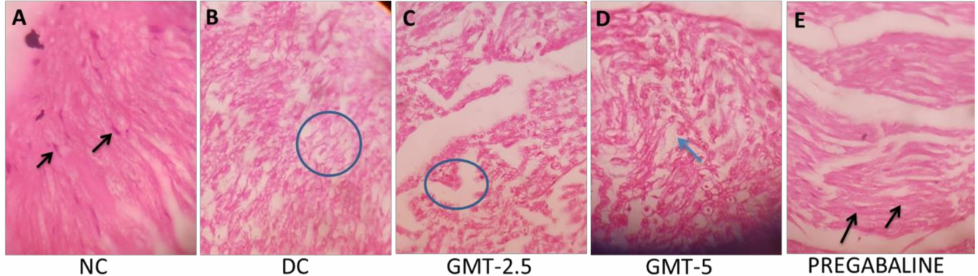
Figure 1. A hematoxylin and eosin section of sciatic nerve tissue ( A ) Control group treated with 0.5% CMC showing the normal arrangement of nerve fibers with elongated Schwann cells. ( B ) Diabetic control group showing axonal swelling. ( C ) Treated with GMT-2.5 showing axonal swelling of nerve fibers. ( D ) Treated with GMT-5 showing the mild derangements of nerve fibers. ( E ) Treated with pregabalin group showing uniformly arranged nerve